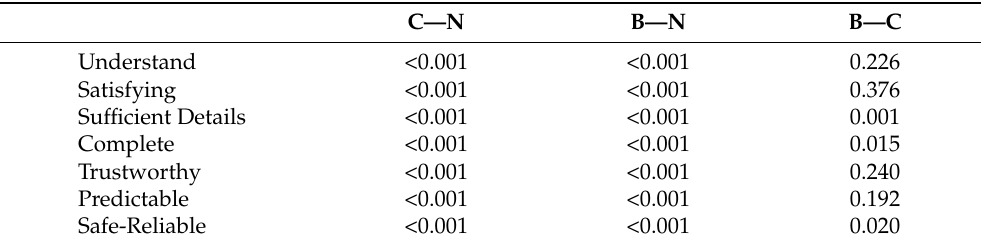
Table 7. Table of the p -values obtained from Dunn’s test for the comparison of the counterfactual explanations.